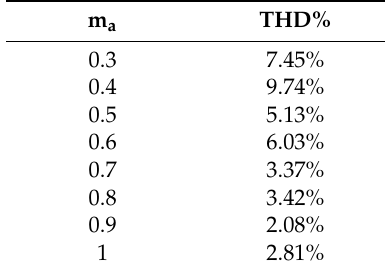
Table 1. Effect of modulation index on total harmonic distortion (THD) of the PWM inverter before using filter.